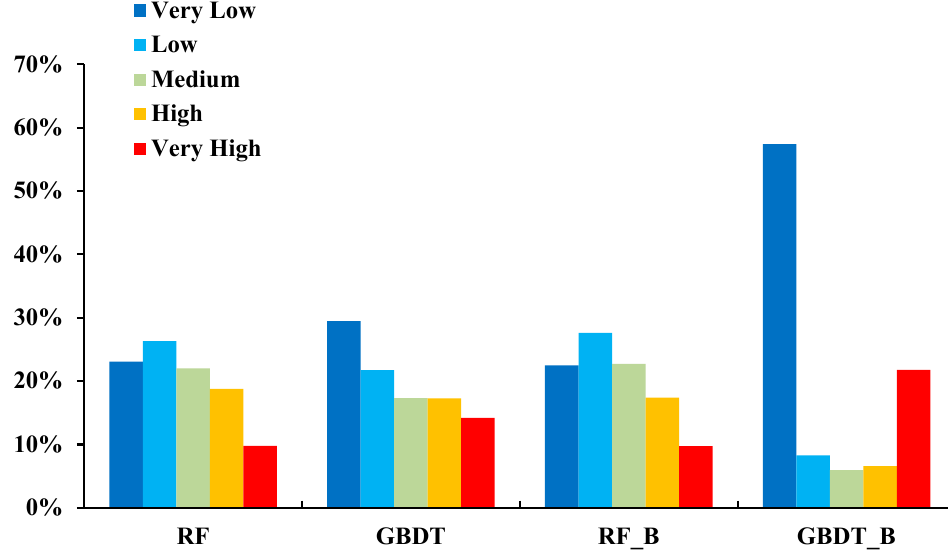
Figure 7. The statistics of each grade of LSMs constructed by the models. Table 4. Quantitative results for the comparison of historical landslides of each grade in LSMs ( P li is the percentage of historical landslides in each grade to total landslides).